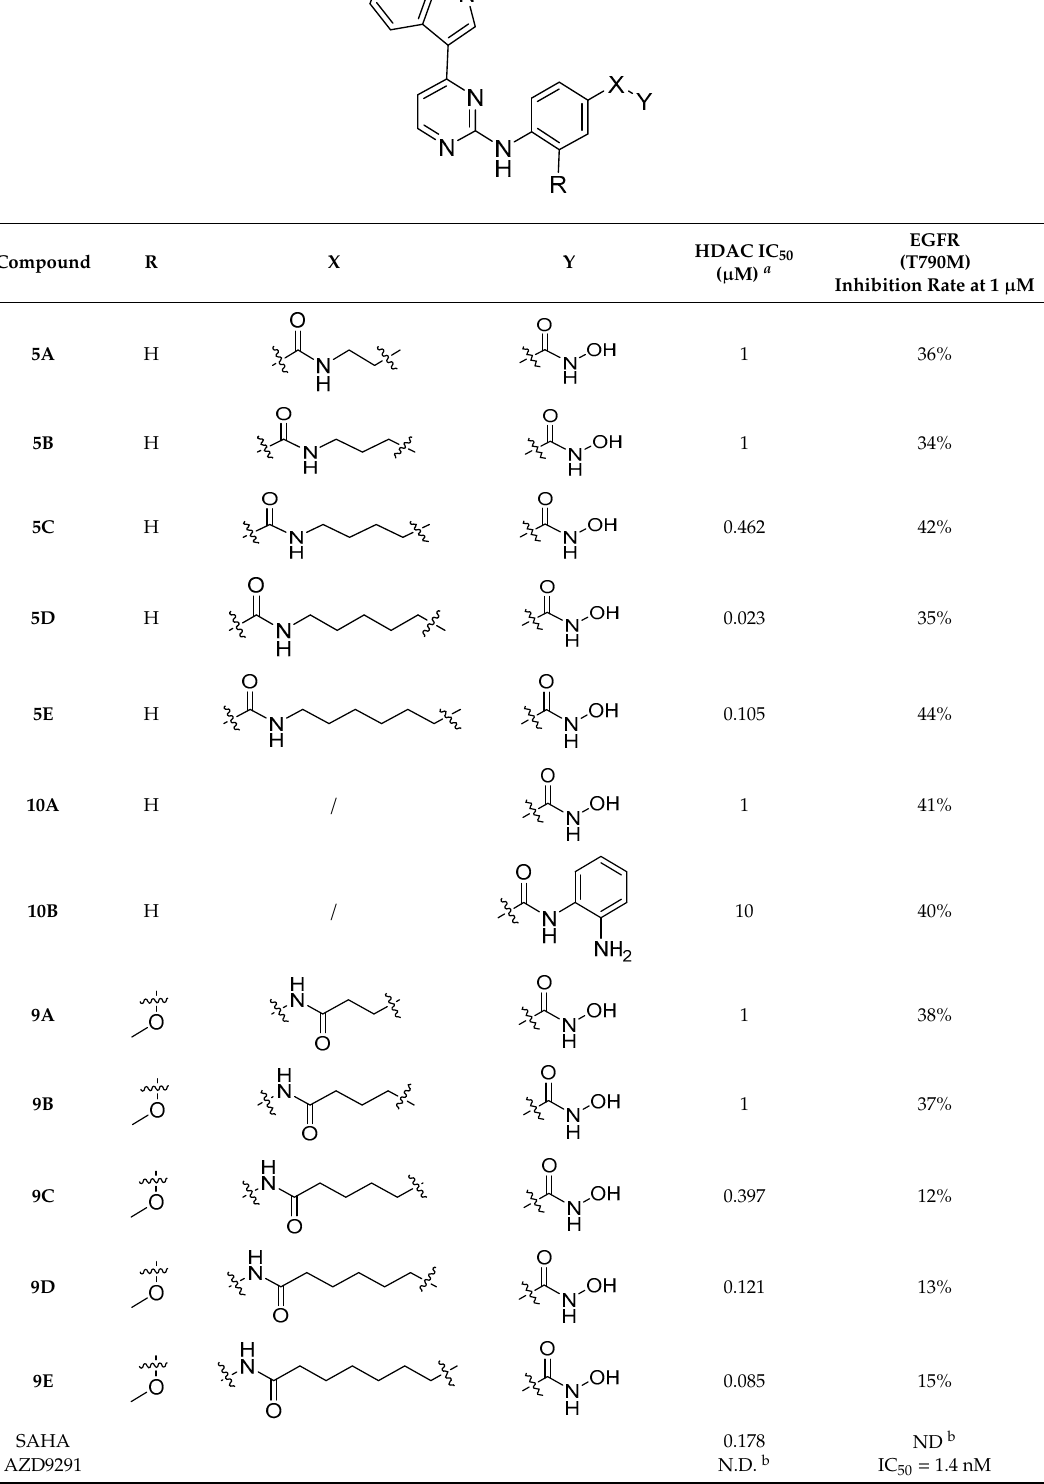
Table 1. HDAC and EGFR inhibitory activity of compounds 5A – 5E , 10A – 10B and 9A – 9E.